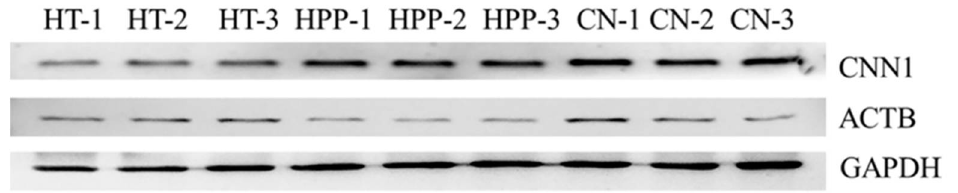
Figure 3. Western blots of CNN1, ACTB and GAPDH. CNN1 and ACTB in 3 come from Group A and Group B, respectively. GAPDH is the reference protein. CN is the sample without treatment, HT is the sample after heat treatment, and HPP is the sample after high-pressure treatment. 1, 2 and 3 are three parallels of the same sample.